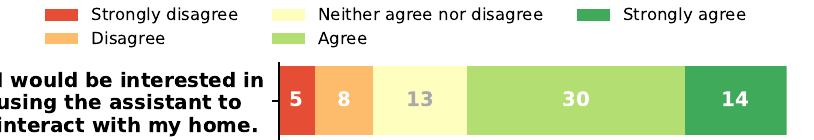
Figure 7. Results for the question about the interest of the participants in using our assistant to interact with their